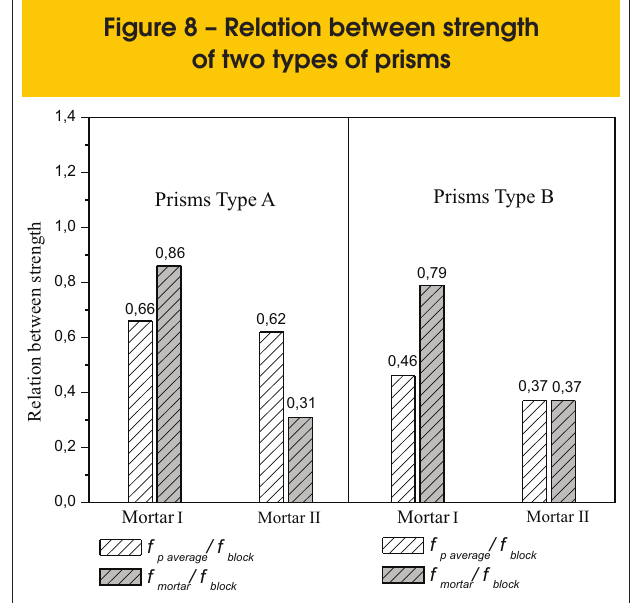
Figure 8 – Relation between strength of two types of